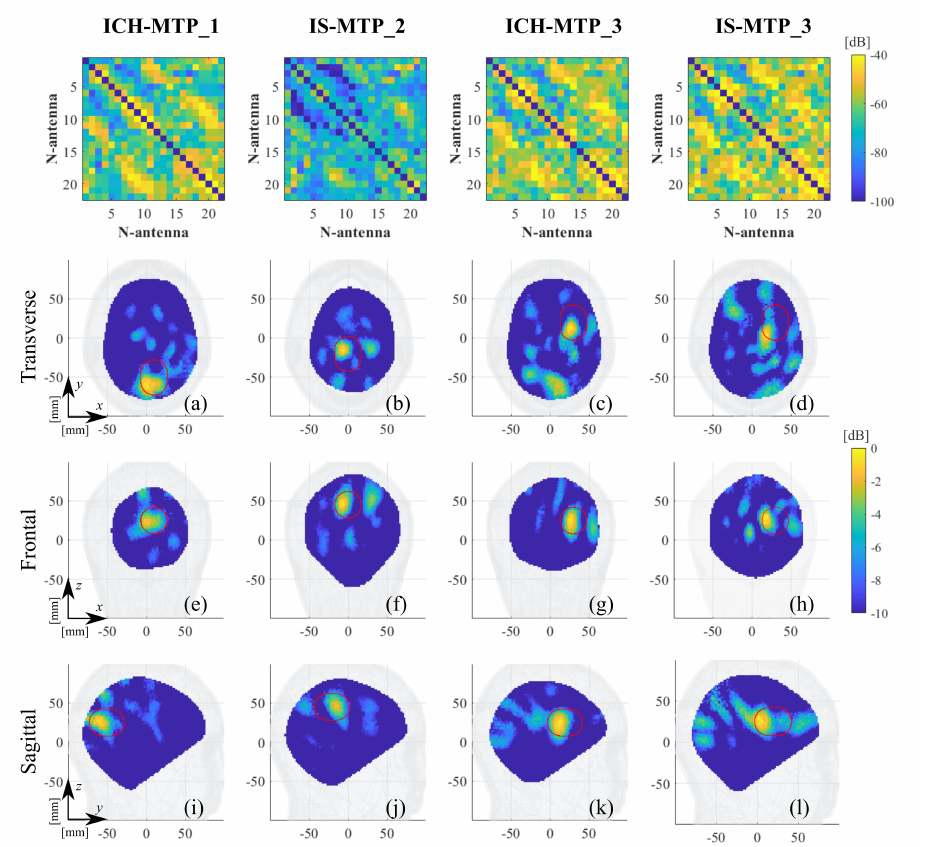
Figure 13. MTP calibrated differential scatting matrices (first row) and reconstructed normalized dielectric contrast values. Columns (from left to right): ICH-MTP_1, IS-MTP_2, ICH-MTP_3, and IS-MTP_3. ( a – d ) Transverse views, ( e – h ) frontal views, and ( i – l ) sagittal views. The expected stroke area is indicated with a red line.